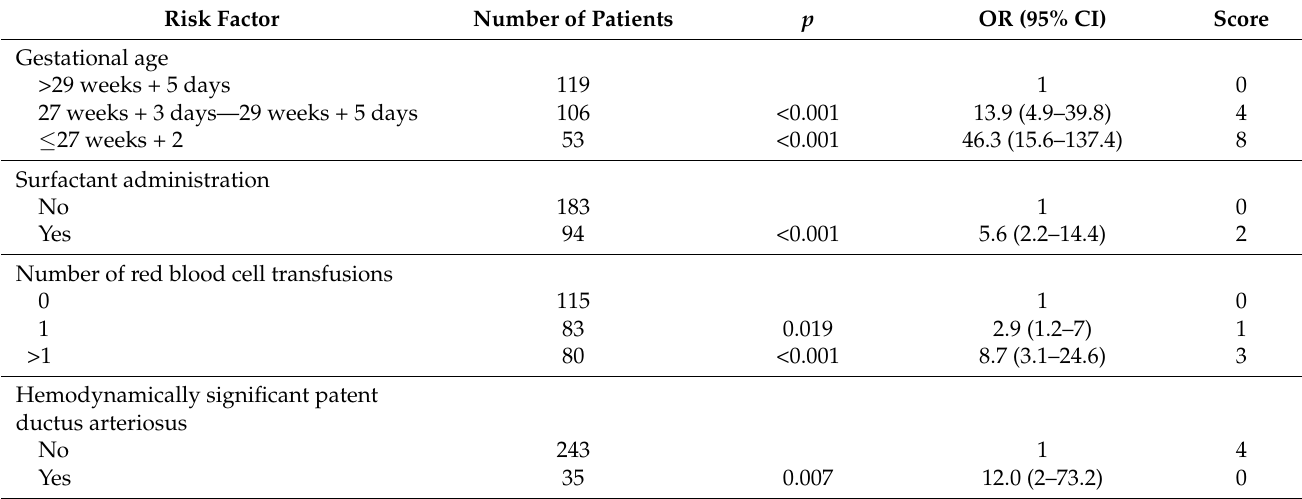
Table 3. Scores of particular risk factors in the predictive model for bronchopulmonary dysplasia .